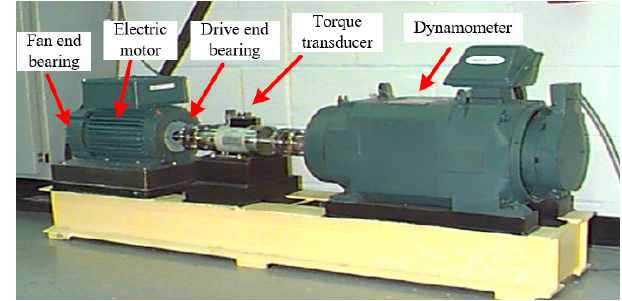
Figure 5. The experimental platform of CWRU.